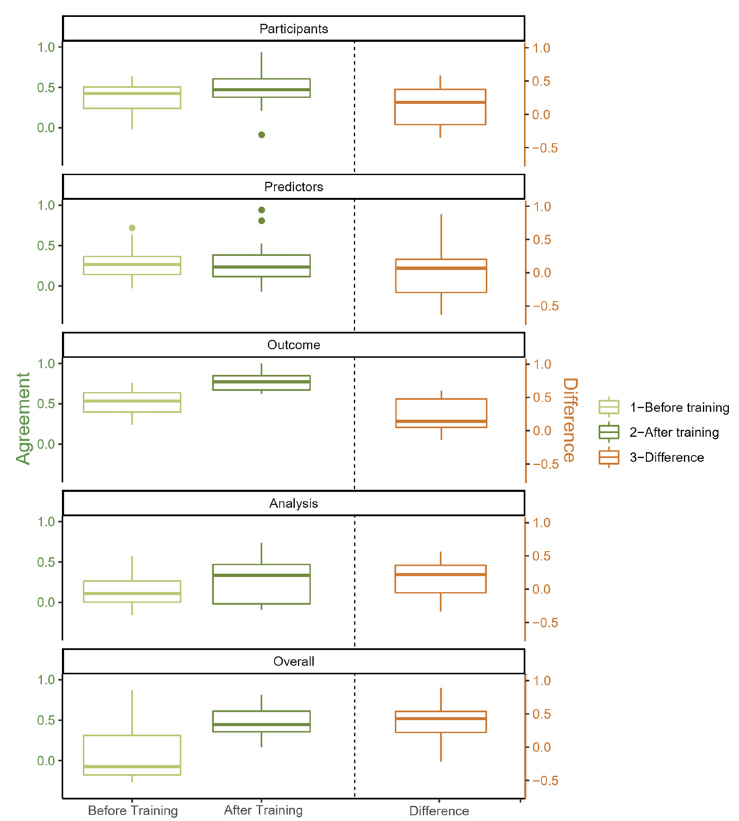
Figure 4. Distribution of pairwise inter-rater agreement in terms of box plots of AC 1 estimates before and after training for the domain-specific and overall ROB ratings (left part), as well as ∆ AC 1 estimates (right part).